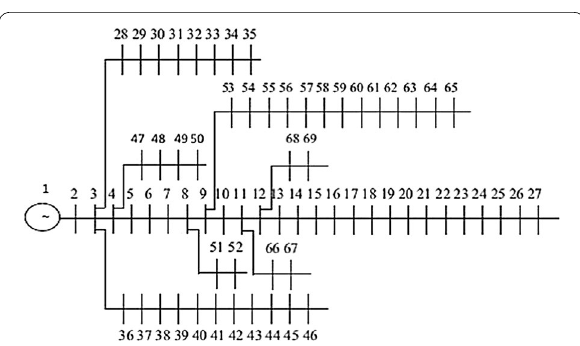
Fig. 4 Single-line diagram of 69-bus system